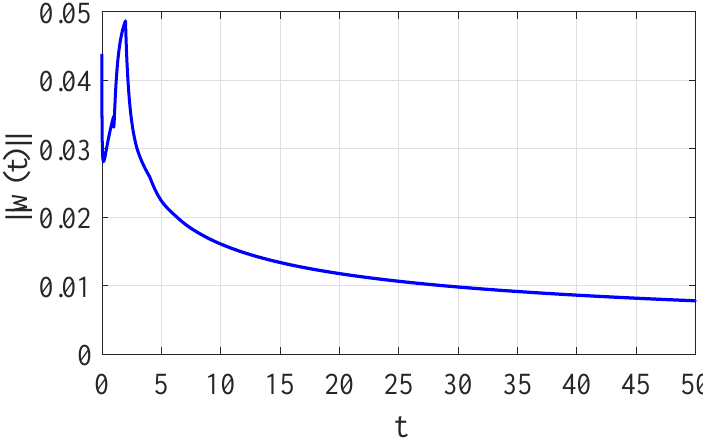
Figure 6. State trajectories of systems (16) and (17) under controller (10) when γ = 0.47. ( a ) p R ( t ) and q R ( t ) ; ( b ) p I ( t ) and q I ( t ) ; ( c ) p J ( t ) and q J ( t ) ; ( d ) p K ( t ) and q K ( t ) .